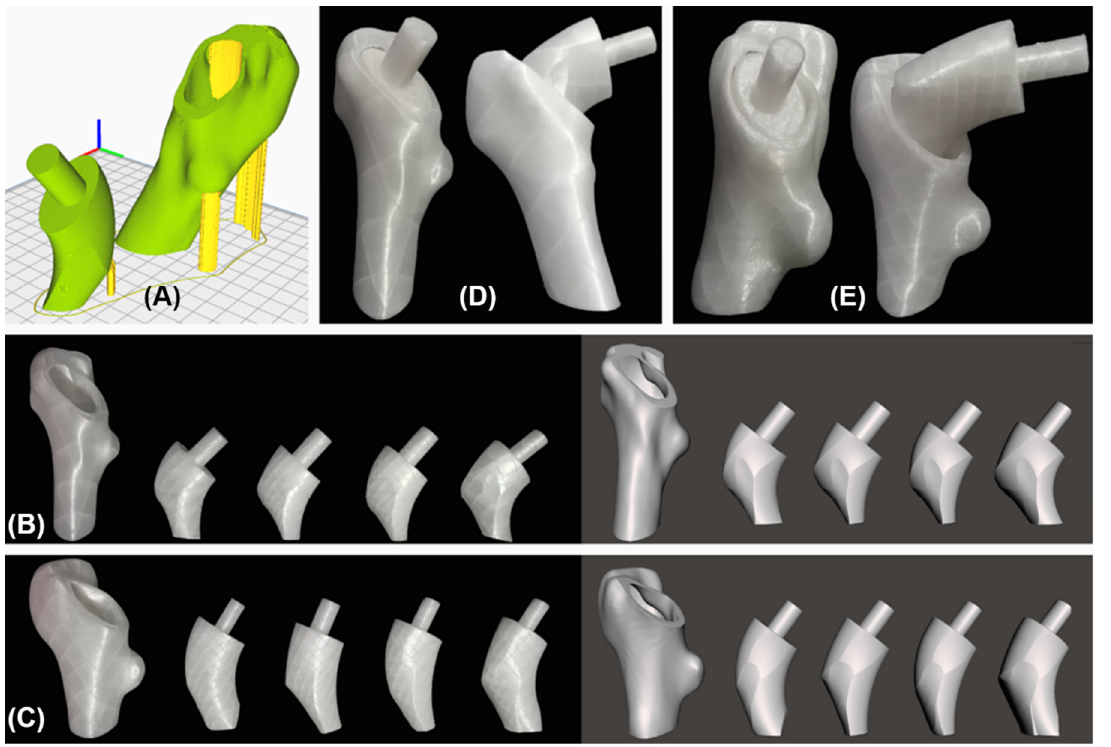
Figure 8. Prototype fabrication. ( A ) Planning using Ultimaker Cura ® . PLA prototypes with their respective STLs for ( B ) GC1 and ( C ) GC2. Evidence of experiments performed for ( D ) GC1 and ( E ) GC2 demonstrating the insertion of regions 1, 2 and 3 (left), but not 4 (right).